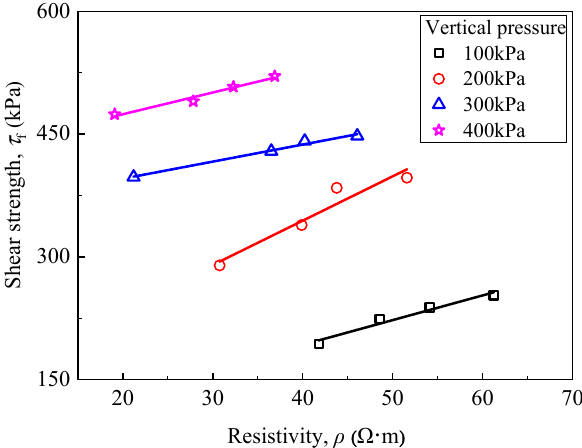
Figure 19. Relationship between resistivity and red mud dosage (under different vertical pressure).